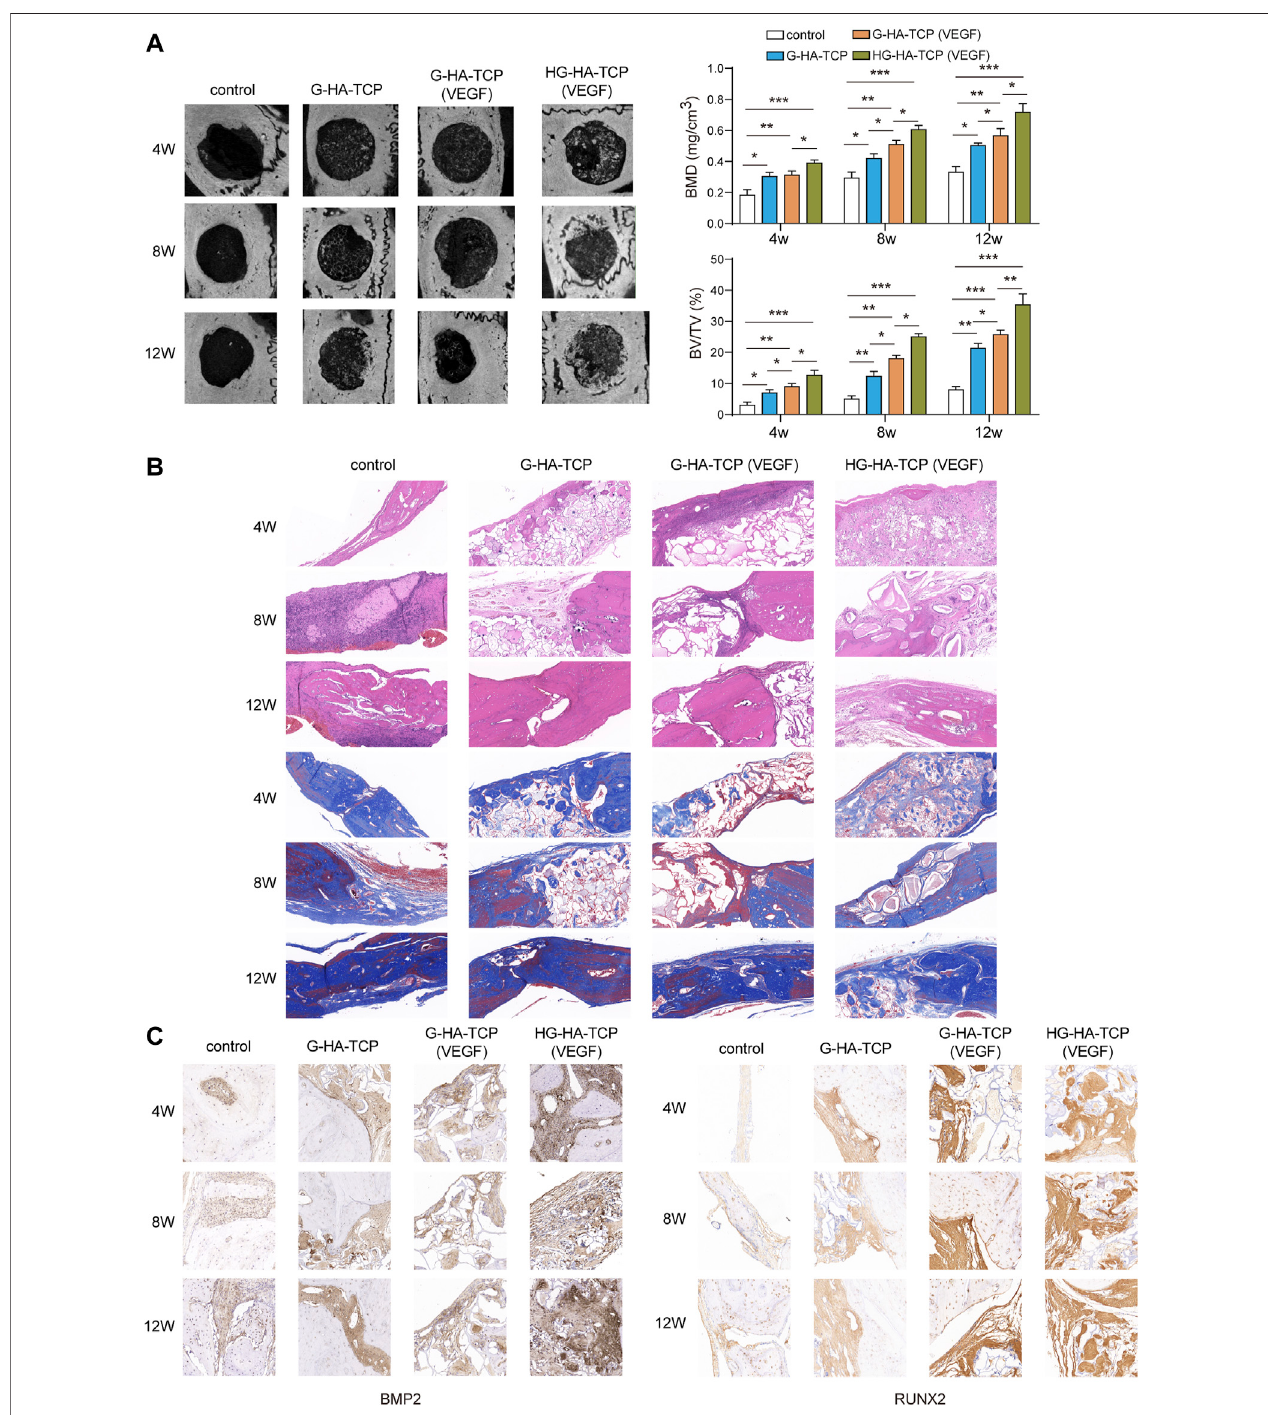
FIGURE 7 | In vivo experiments con fi rmed that HG-HA-TCP (VEGF) could accelerate bone regeneration. (A) Micro-CT observation of bone regeneration. (B) H&E andMassonstainingforthemeasurementofbonerepair. (C) ImmunohistochemicaldetectionofBMP2,CD31,RUNX2,andvWFexpressions n =6.* p < 0.05,** p < 0.01, *** p <